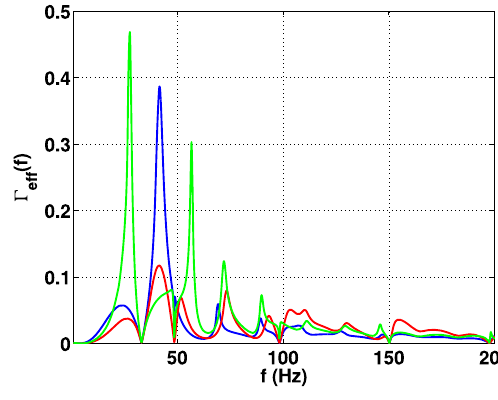
Fig. 67 Effective overlap ( T ) ( V ) ( S ) S S functions for S h , h , h , for the multibaseline network formed from the LIGO Hanford, LIGO Livingston, and Virgo ( T ) ( f ) is shown in detectors. (cid:13) eff ( V ) ( f ) is shown in red ; blue ; (cid:13) eff ( f ) is shown in (cid:13) ( S ) eff